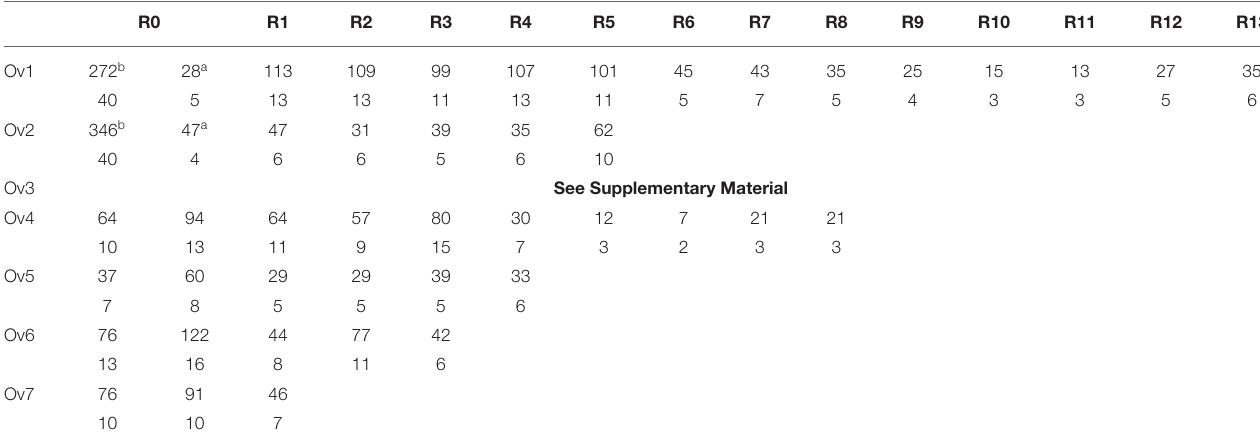
TABLE 1 | Overview of the performance of the experimental animals during the various phases of the reversal learning experiment depicted as number of errors per